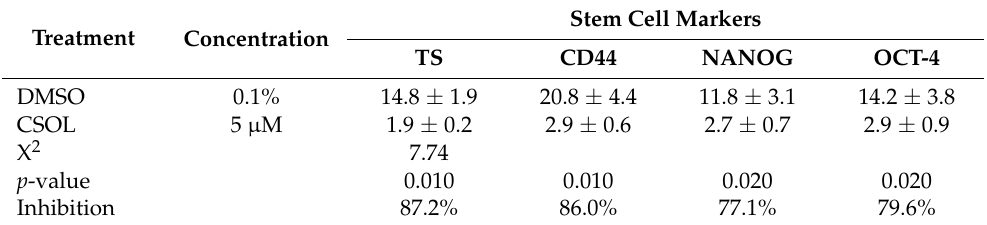
Table 6. Experimental modulation of stem cell markers in the lapatinib-resistant (LAP-R) breast cancer